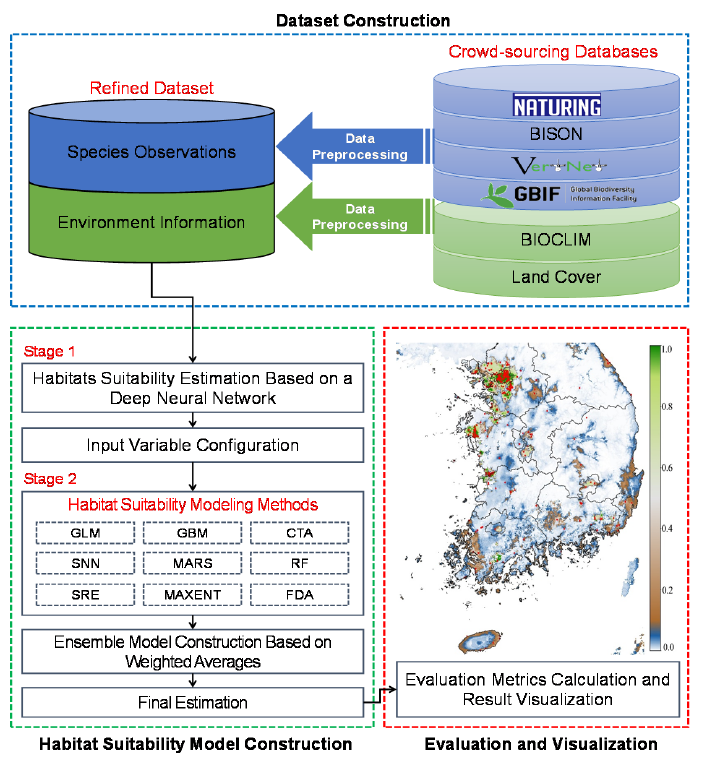
Figure 1. Overall process of the TSEM.